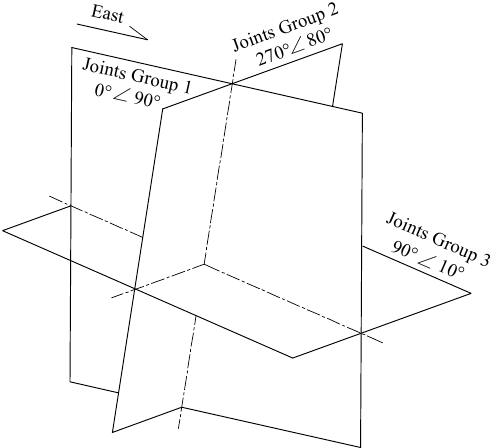
Figure 5. Three predominant sets of rock joints idealised from the Yanqianshan iron mine for physical model testing.